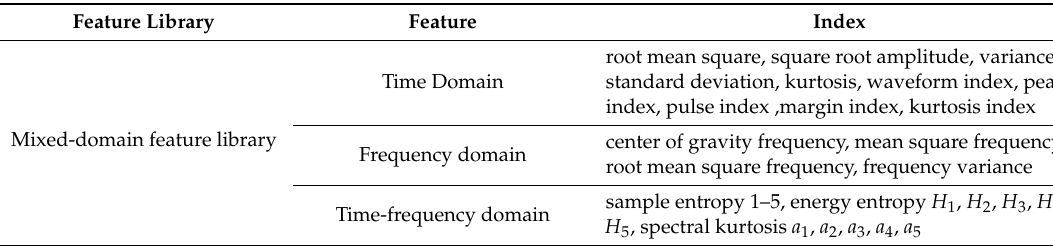
Table 2. Mixed feature library of stator current